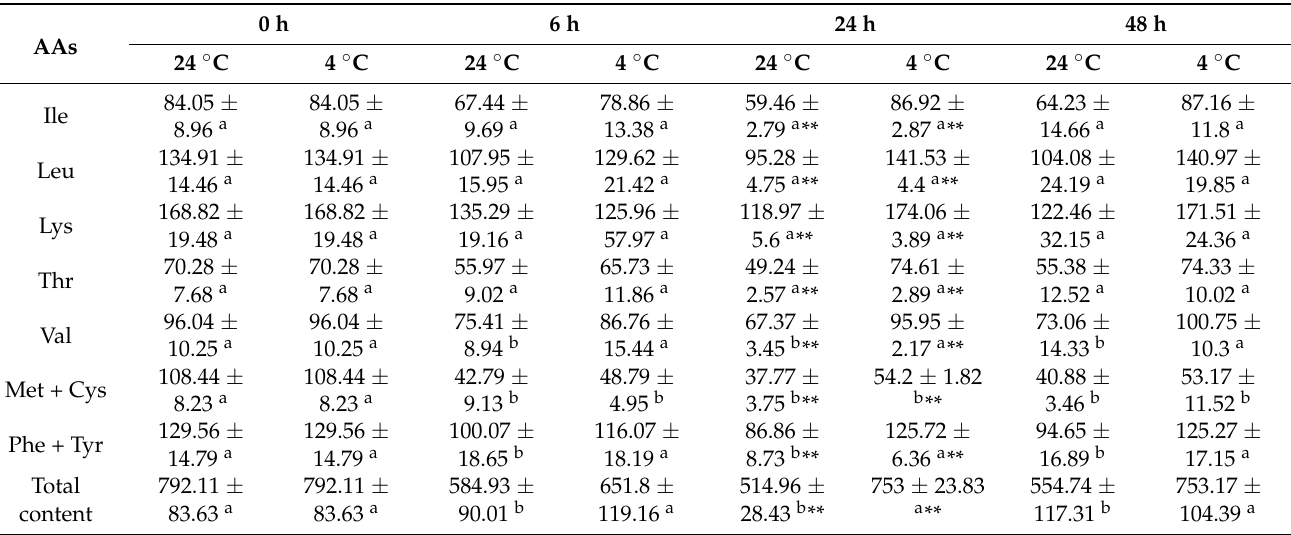
Table 6. Amino acids (AAs) content per gram of protein of American shad as storage progressed at 24 ◦ C (unrefrigerated) and 4 ◦ C